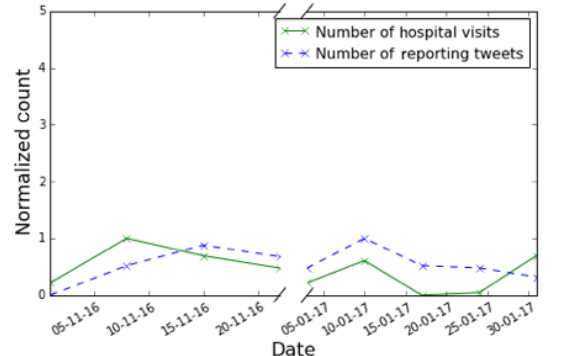
Fig. 7 Count of Arabic tweets (classified as nonself) versus count of actual hospital visits.